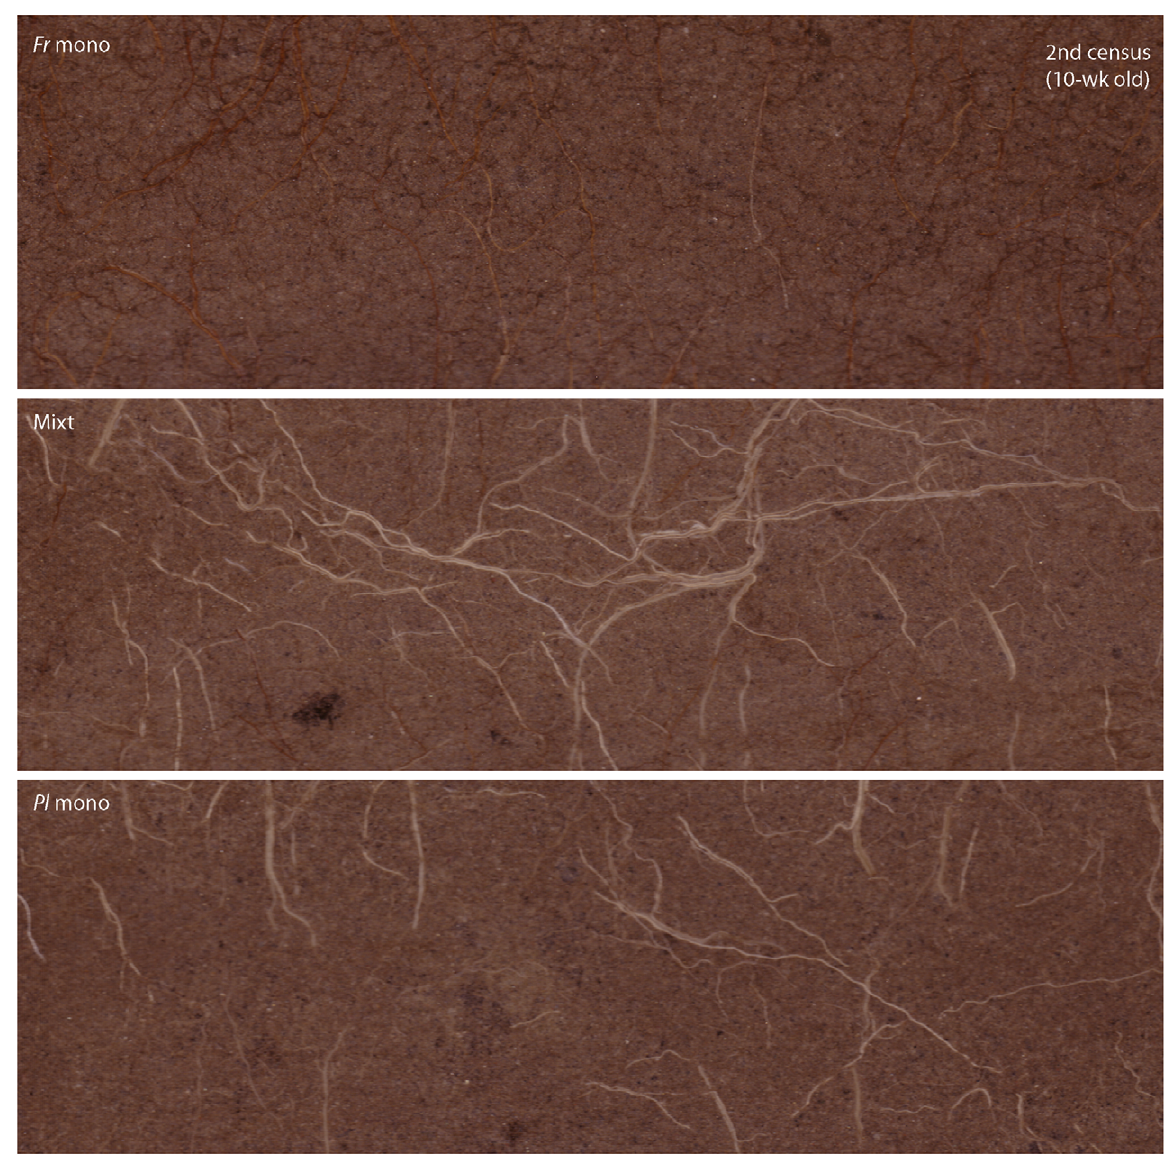
Figure 2. Minirhizotron images at 10 cm depth taken ten weeks after the start of the experiment. Note the abundance of P. lanceolata ( Pl , white roots) and absence of F. rubra ( Fr , brown roots) in mixtures images compared to the respective